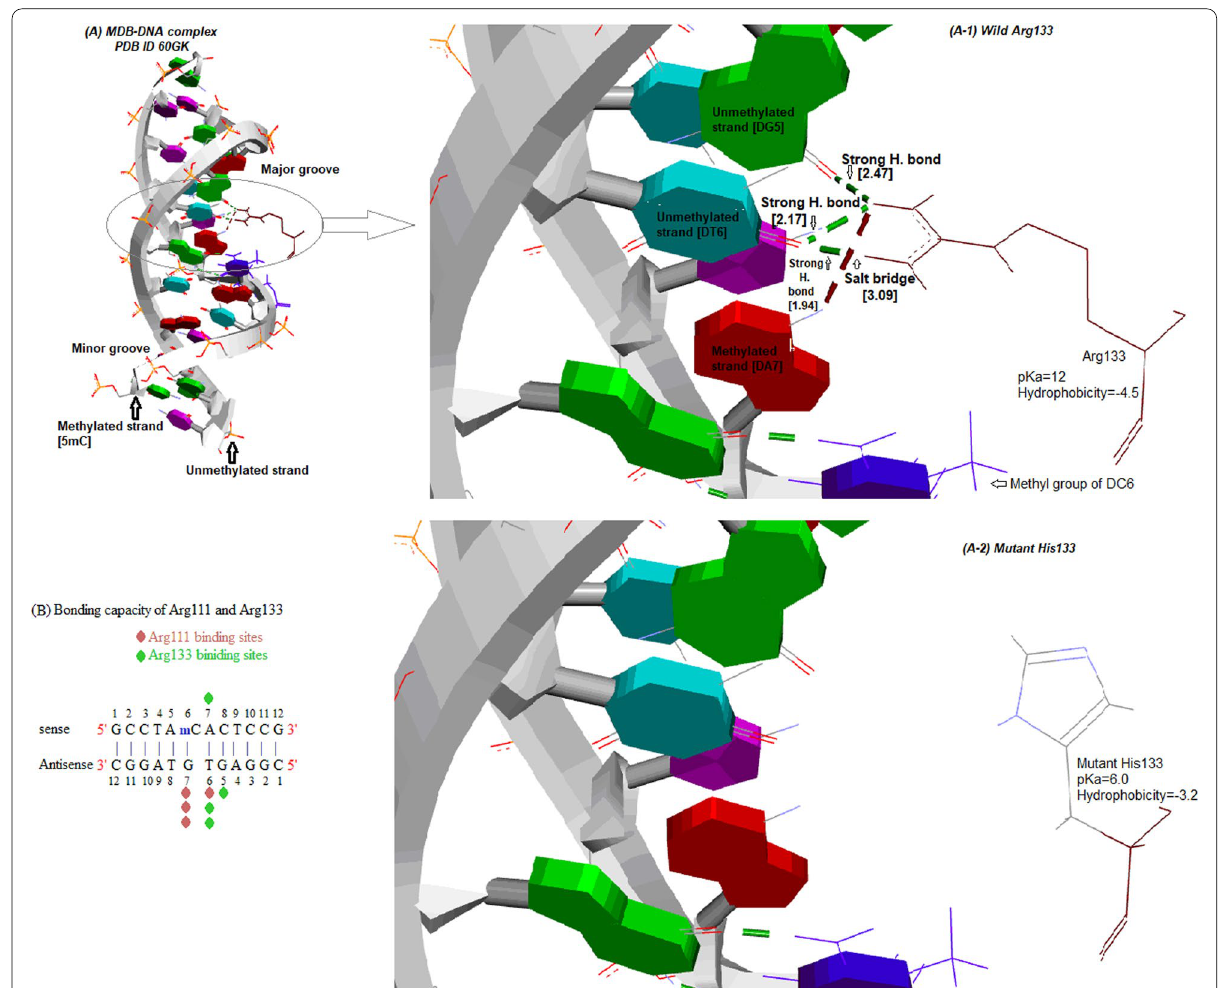
Fig. 3 Molecular docking of R133H showed differential capacity bonding between arginine and histidine residues. A The major groove of DNA targeting Arg133; A‑1, the capacity bonding of the wild Arg133; A‑2, the capacity bonding of the mutant His133; B the differential capacity bonding between Arg111 and